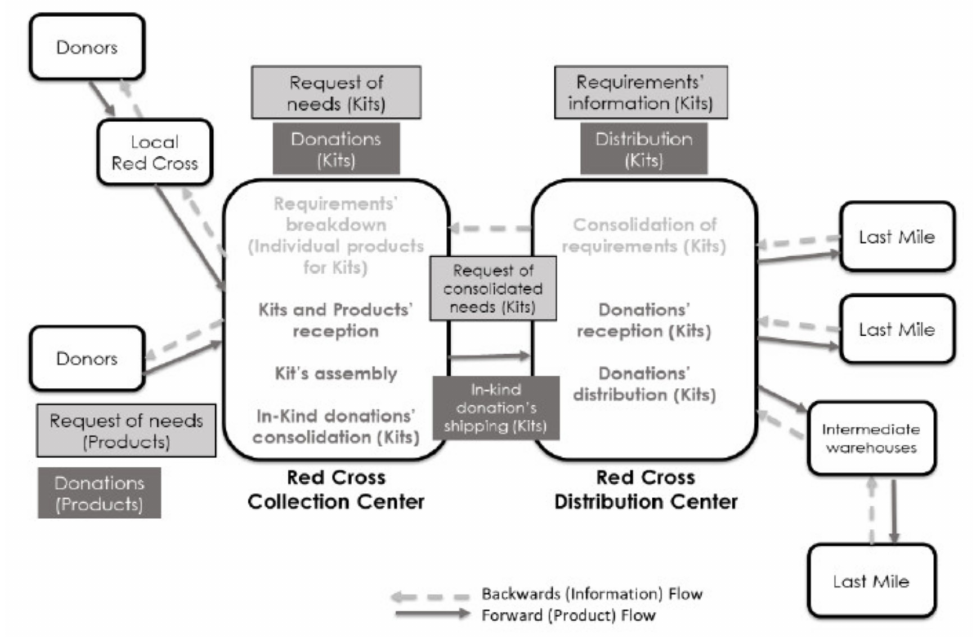
Figure 1. Mapping of Mexican Red Cross supply chain for disaster relief operations (Source: Own